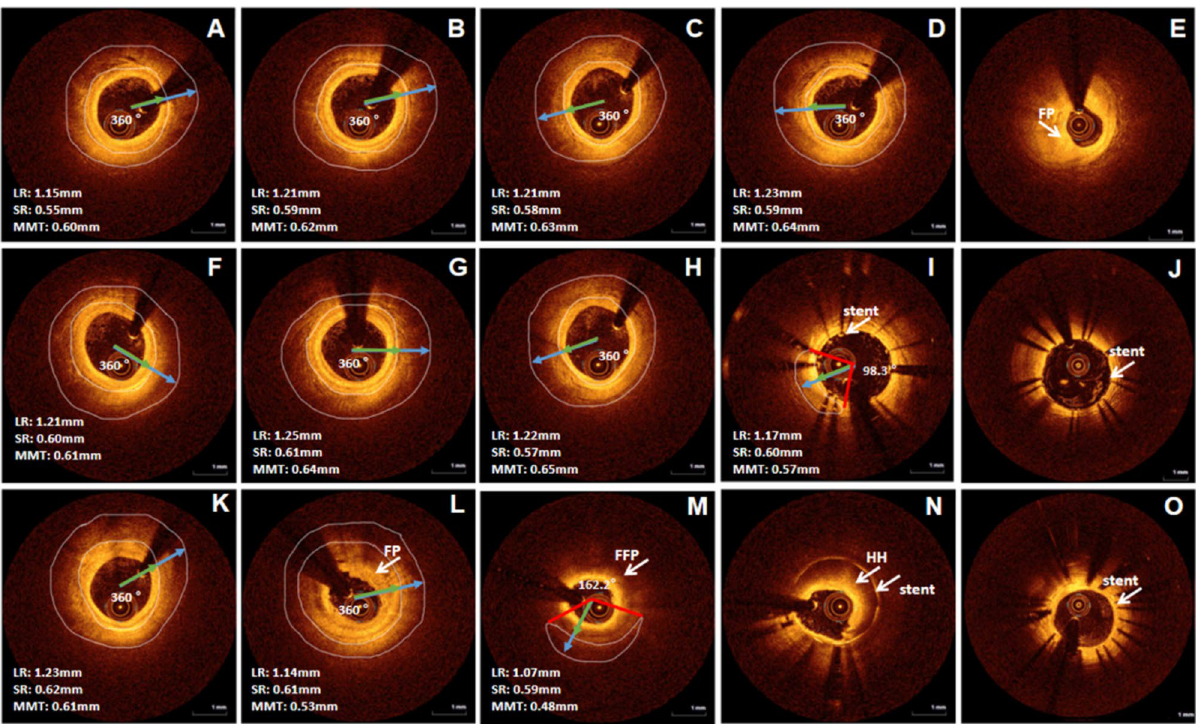
Figure 3. The representative case was about the dynamic observation of the MB change detected by OCT through 1-year follow-up. The male patient with MB was 57 years old, and two DESs (3.5 × 36 mm, 3.5 × 12 mm) were implanted in proximal and middle LAD. ( A – E ) Before PCI. ( A ) Showed the MMT was 0.60 mm, and the MA was 360°; ( B ) showed the MMT was 0.62 mm, and the MA was 360°; ( C ) showed the MMT was 0.63 mm, and the MA was 360°; ( D ) showed the MMT was 0.64 mm, and the MA was 360°; ( E ) showed there was FP in the middle LAD. ( F – J ) Immediately post PCI; ( F ) showed the MMT was 0.61 mm, and the MA was 360°; ( G ) showed the MMT was 0.64 mm, and the MA was 360°; ( H ) showed the MMT was 0.65 mm, and the MA was 360°; ( I ) showed the MMT was 0.57 mm, the MA was 98.3°, and the implanted coronary stent significantly reduced the MB size; ( J ) showed there was coronary stent in the middle LAD. ( K – O ) 1-year follow-up post PCI; ( K ) showed the MMT was 0.61 mm, and the MA was 360°; ( L ) showed the MMT was 0.53 mm, the MA was 360°, and FP slightly influenced the MB size; ( M ) showed the MMT was 0.48 mm, the MA was 162.2°, and FFP significantly decrease the MB size; ( N ) showed MB disappeared because stent implantation and HH; ( O ) showed the good endothelialization of coronary stents. Scale bar: 1 mm. DES drug eluted stent, FP fibrous plaque, FFP fibrous-fatty plaque, HH heterogeneous hyperplasia.